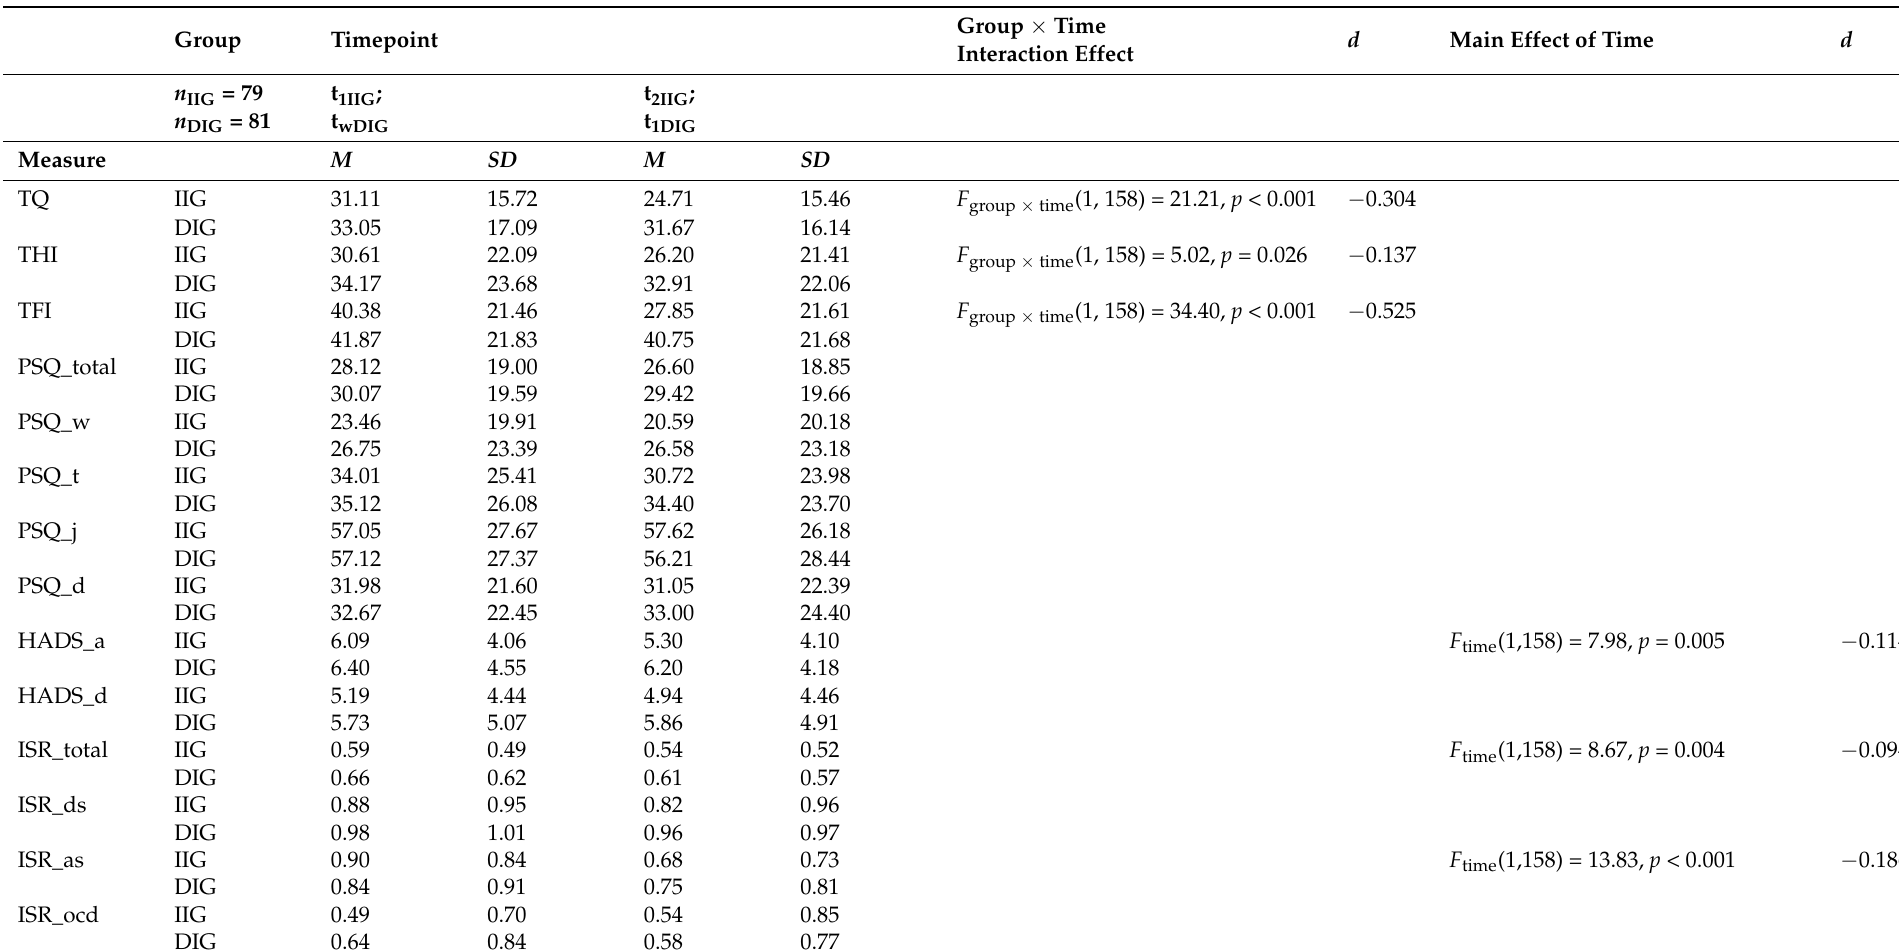
Table 2. Means, standard deviations, and significant main effects of “time” or “group” × time interaction effects for tinnitus-related distress, perceived stress, and psychological epiphenomena in the immediate vs. delayed intervention